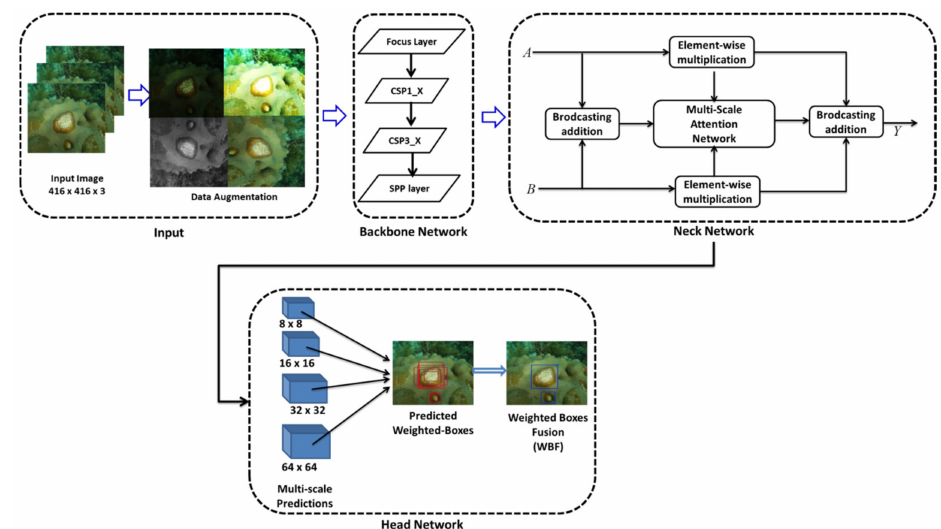
Figure 2. Architecture of the MAFFN-YOLOv5 model.